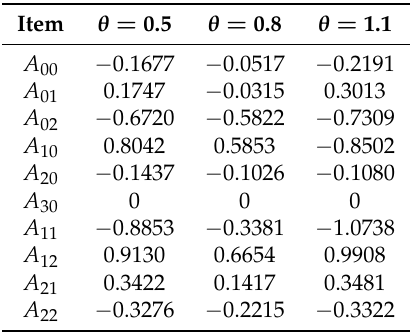
Table 2. The coefficients of the propeller thrust coefficient